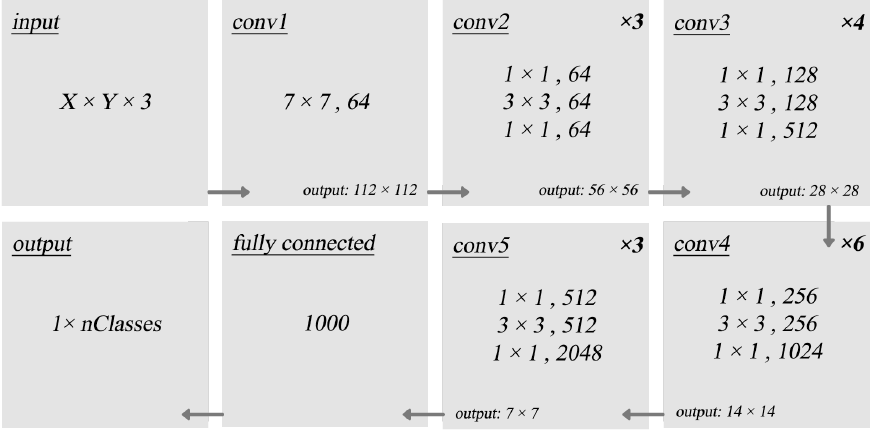
Figure 5. Architecture of ResNet50 base model